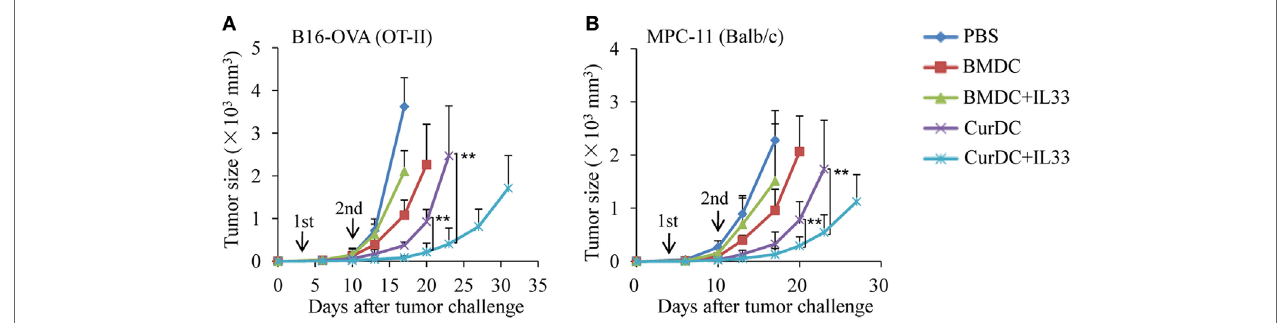
FigUre 4 | Interleukin (IL)-33 promotes dectin-1-activated dendritic cell (DC)-induced antitumor efficacy in vivo . (a) OT-II mice were injected subcutaneously with 1 × 10 5 B16-OVA cells. On day 3 after tumor challenge, mice (five mice/group) were given two weekly subcutaneously immunizations with 1 × 10 6 OVA-peptide- pulsed BMDCs or CurDCs. In addition, some of the mice immunized with BMDCs or CurDCs were given IL-33 (250 ng/mouse) every 3 days, beginning on the day